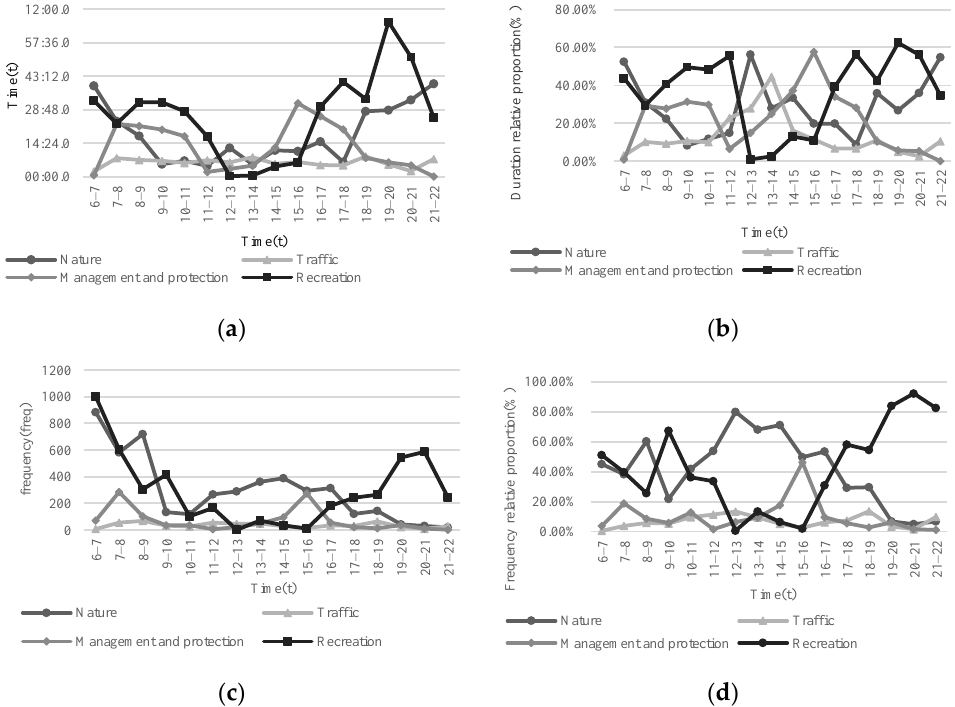
Figure 5. Diurnal variation characteristics of duration, frequency and relative proportion of various sound sources; ( a ) diurnal variation of sound duration; ( b ) diurnal variation characteristics of relative proportion of sound duration; ( c ) diurnal variation of sound frequency; ( d ) diurnal variation characteristics of relative proportion of sound frequency.